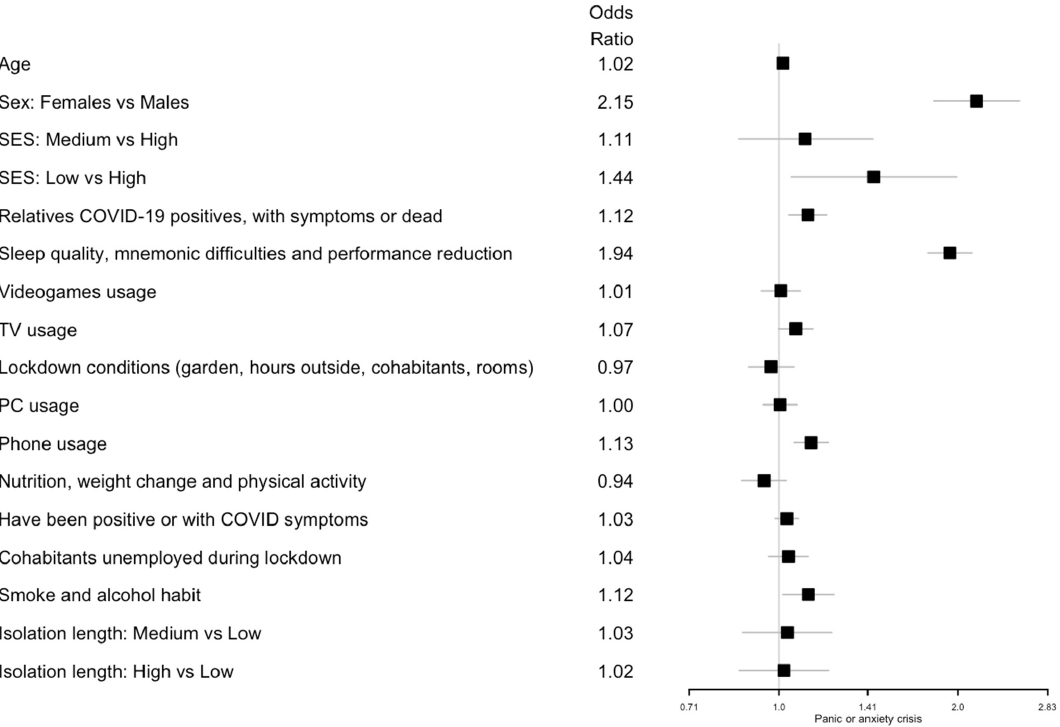
Figure 4. Forest plots for the effect of the covariates on panic or anxiety crises. The squares represent the odds ratios and the lines depict the confidence intervals estimated by the ordinal logistic regression.